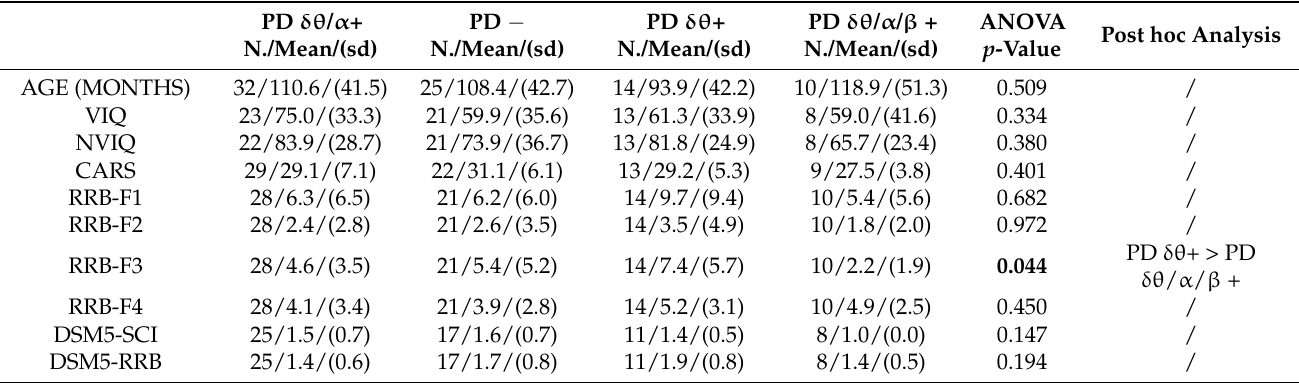
Table 3. Correlations between ASD groups and demographic, cognitive, and behavioral